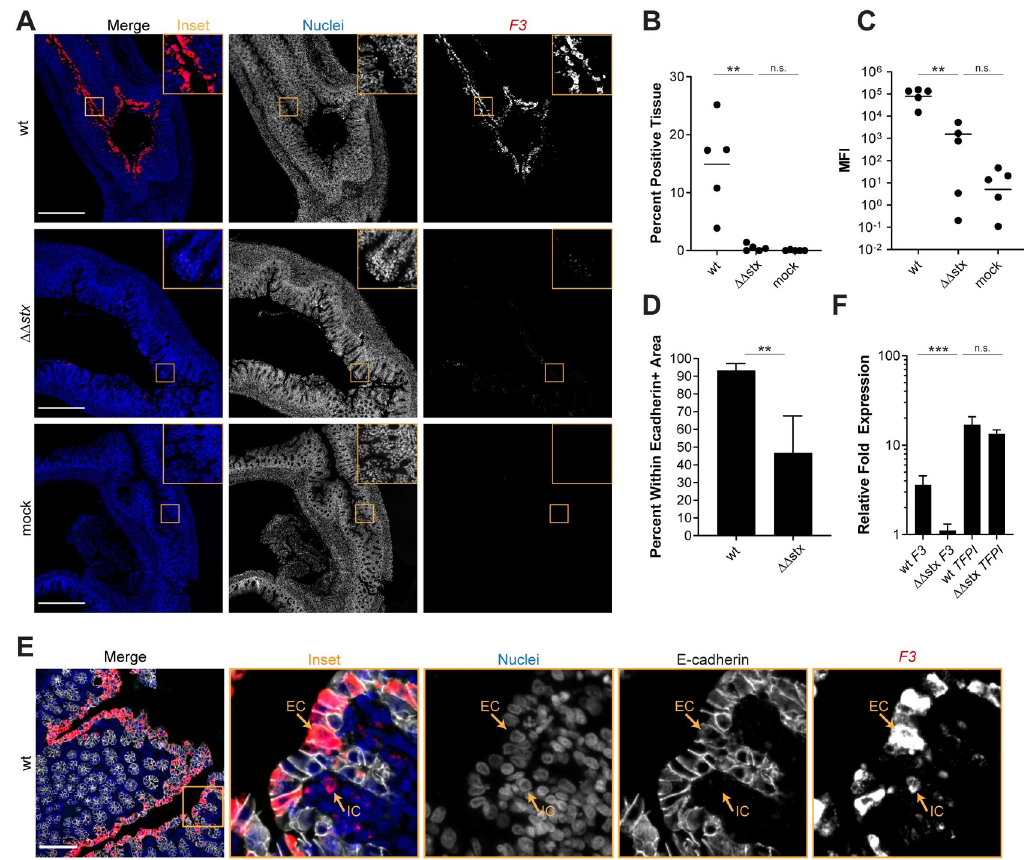
(red) and DAPI (blue). Scale bar is 500 μ M. (B) Percentage of tissue section with F3 signal from individual colons. Distributions compared using Mann-Whitney U test, p < 0.01 ( �� ), n.s. indicates not significant. (C) Mean fluorescent intensity (MFI) from individual colons plotted with mean. Distributions compared using Mann-Whitney U test, p < 0.01 ( �� ), n.s. indicates not significant. (D) Percent F3 signal within E-cadherin positive cells. Distributions compared using the Mann-Whitney U test, p < 0.05 ( � ). (E) Sections stained with a probe to rabbit F3 mRNA (red), DAPI (blue), and anti-E-cadherin antibody (white). Scale bar is 500 μ M. Example immune cell (IC) and epithelial cell (EC) are indicated. (F) Normalized expression of F3 and TFPI in HT29 cells infected with WT EHEC, ΔΔ stx EHEC, or PBS. Expression levels compared with a Students two-tailed t-test, p < 0.001 ( ��� ), n.s. indicates not